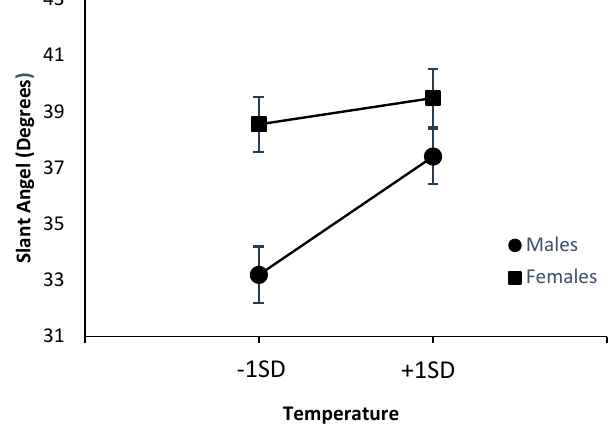
Figure 2. Effects of temperature on estimated slant angle.